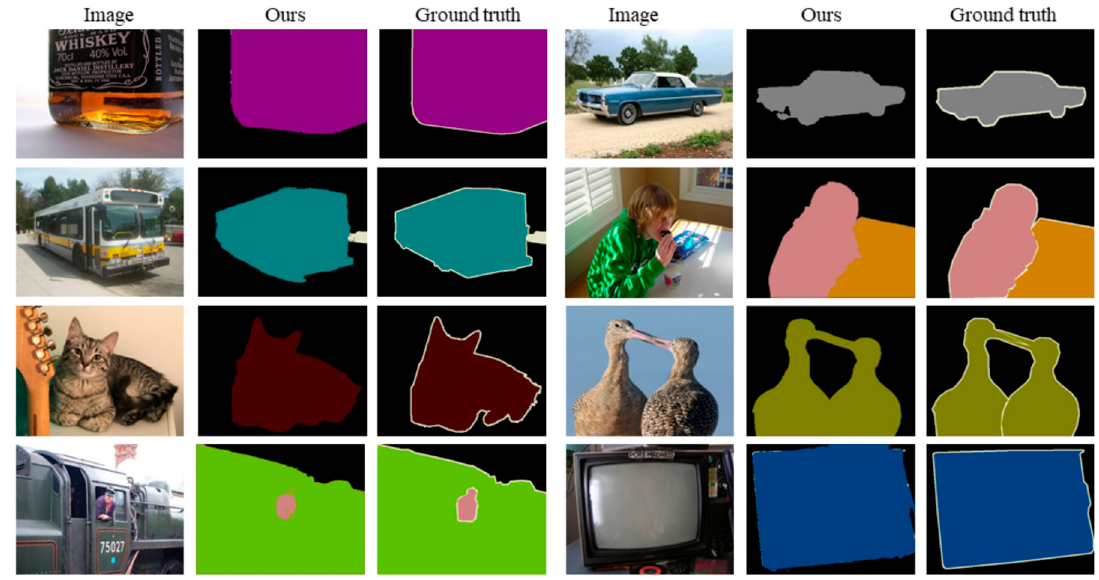
Figure 7. Some segmentation results for segmentation by our algorithm.